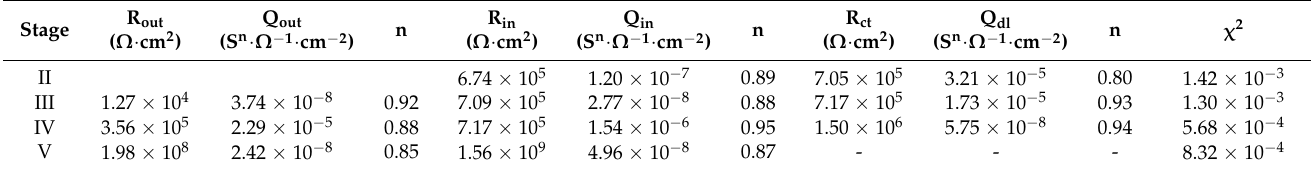
Table 3. Equivalent circuit data for PEO coatings at various